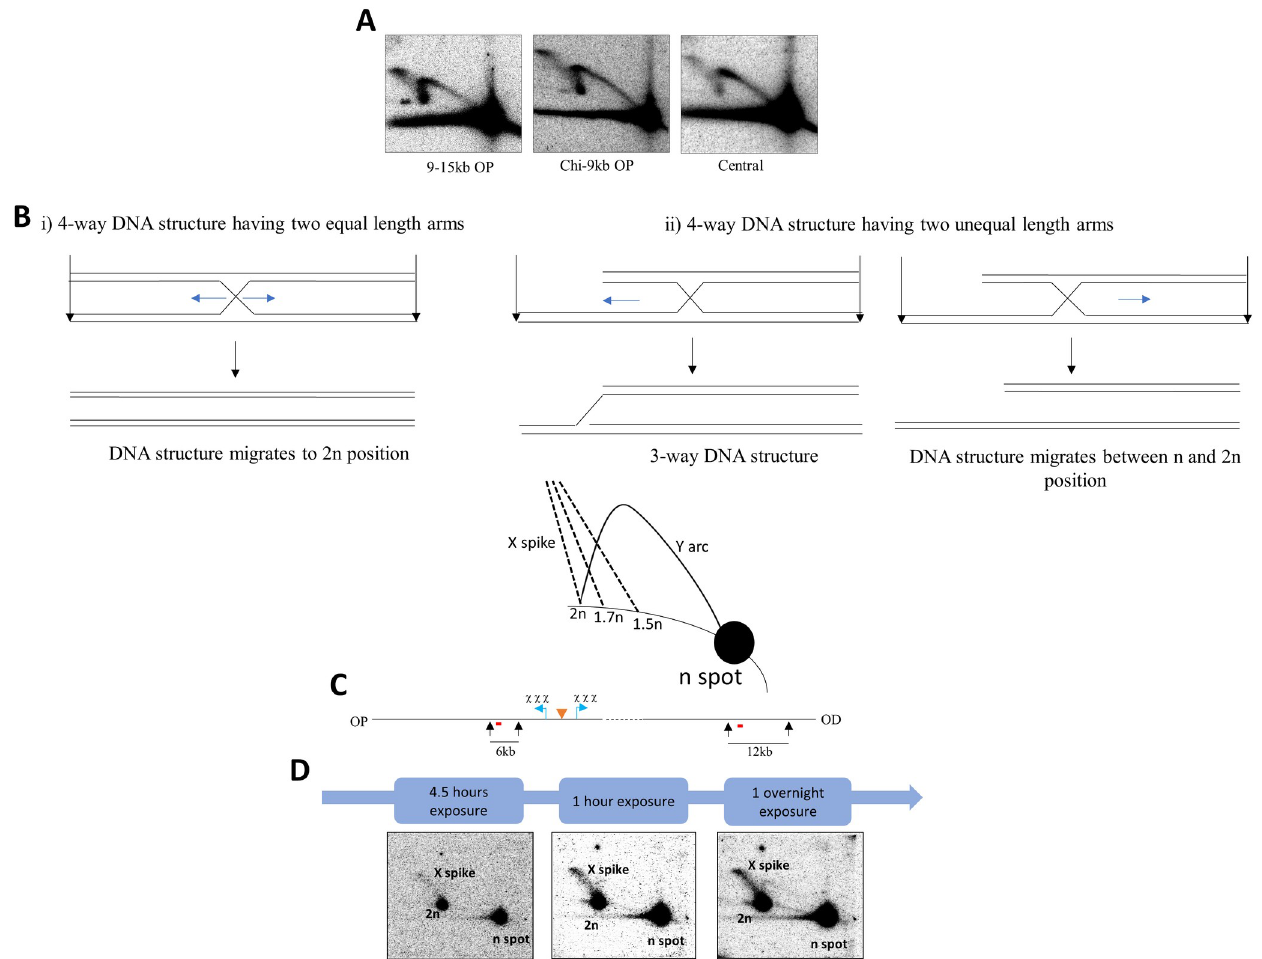
Fig 5. 2-D gels of non-crosslinked DNA molecules and determination of the nature of the branched DNA structures accumulated along the X-spike that is detected in the Southern blot of 2-D gel electrophoresis of crosslinked DNA molecules from a Δ ruvAB strain. A) 2-D gels of non-crosslinked 9–15 kb OP, Chi-9 kb OP and central fragments for Δ ruvAB strains (DL7259, DL7253 and DL7272, respectively) containing the palindrome, grown in the presence of 0.2% arabinose for 60 minutes. B) Schematic representation of the predictions about the emplacement where the X-spike reaches the linear arc according to the two different hypotheses C) NotI digestion map of the E . coli chromosome in which the location of the palindrome is shown by an orange triangle and the Chi sites are indicated by blue arrows. NotI recognition sites of interest and the fragments resulting from NotI digestion are marked by black arrows and numbers (in kb), respectively. The prpD and ydeA probes that were used to detect the 6kb and 12kb fragments are marked by red lines placed below the restriction fragments. OP and OD mean origin-proximal and origin-distal sides. D) Detection of the n spot using prpD probe that recognises the 6kb prpD fragment and the 2n spot using ydeA probe that recognises a 12 kb fragment approximately 1.2Mb away from the palindrome. The fragments resulted from NotI digestion of crosslinked DNA isolated from bacterial cell cultures grown in LB medium supplemented with 0.2% arabinose for 60 minutes. With increasing film exposure time, both linear and branched DNA species become detectable. Therefore, after 4.5 hours of exposure, the blot starts to show the 6kb linear and 12kb branched fragments as detected by the prpD probe and the 12kb linear fragment as detected by the ydeA probe. After overnight exposure the 12 kb branched fragment becomes strongly detectable. The strain used was DL7577 ( Δ ruvAB lacZ ::246).